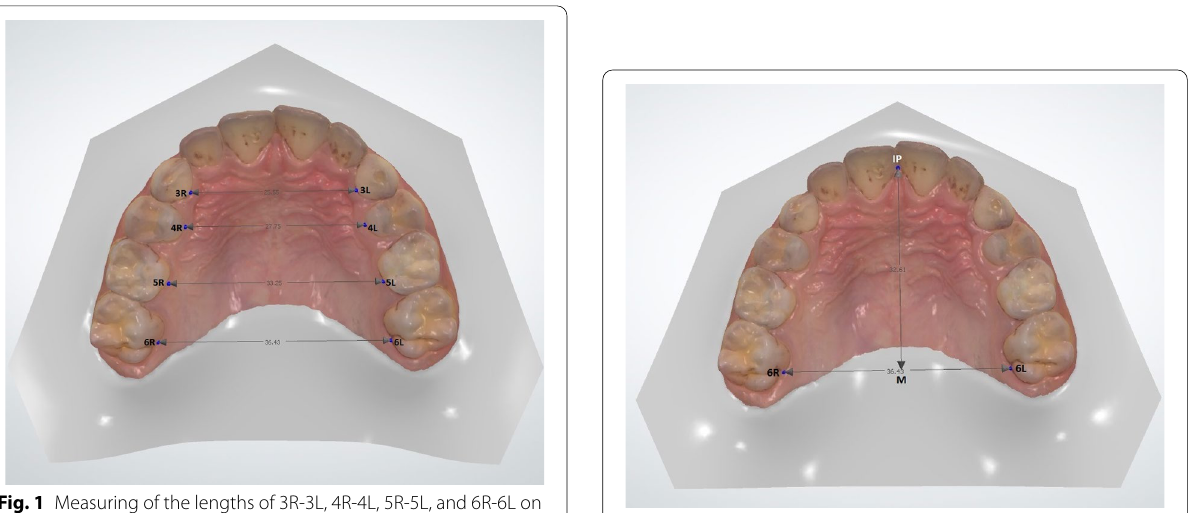
Fig. 3 Measuring of the lengths of IP-M on a 3D digital